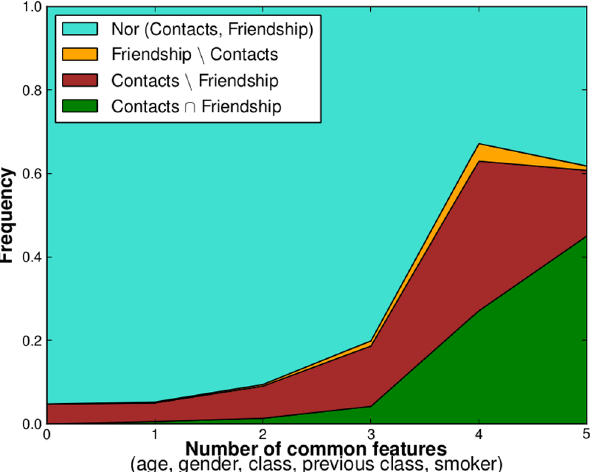
Fig 7. Fraction of friendship and contact links as a function of the number of features shared by two